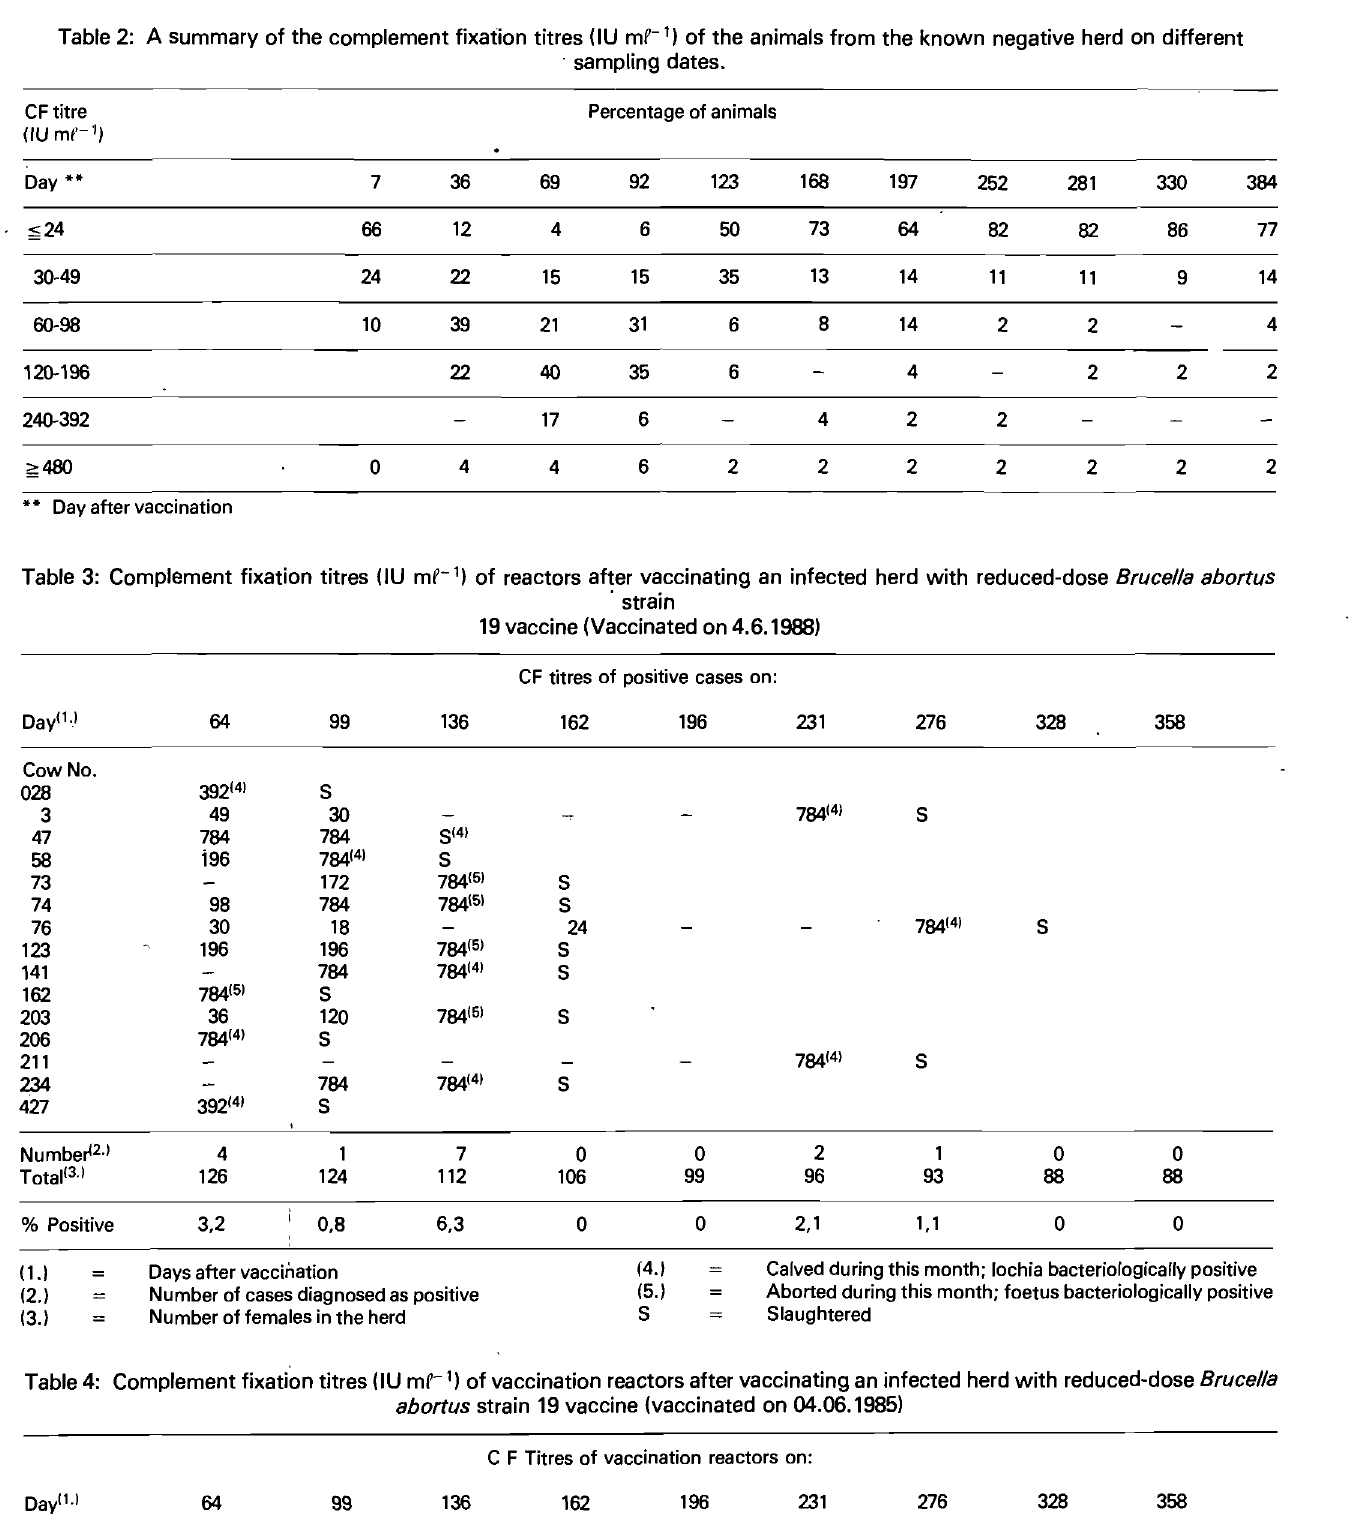
Table 4: Complement fixation titres (IU mp-I) of vaccination reactors after vaccinating an infected herd with reduced-dose Brucella abortus strain 19 vaccine (vaccinated on 04.06.1985) C F Titres of vaccination reactors